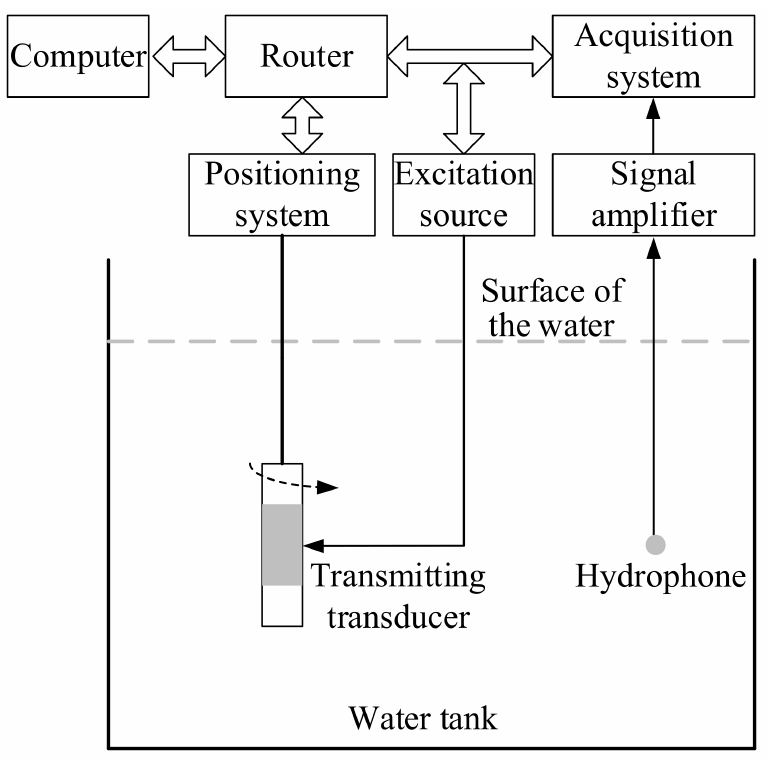
Figure 9. Schematic diagram of the underwater acoustic response experimental device for transmit- ting piezoelectric